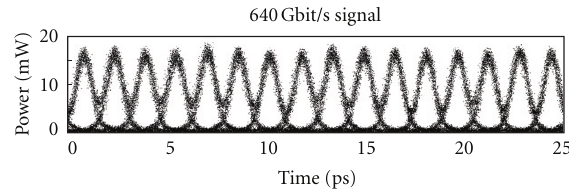
Figure 11: Eye diagram of the 640 Gbit/s OTDM